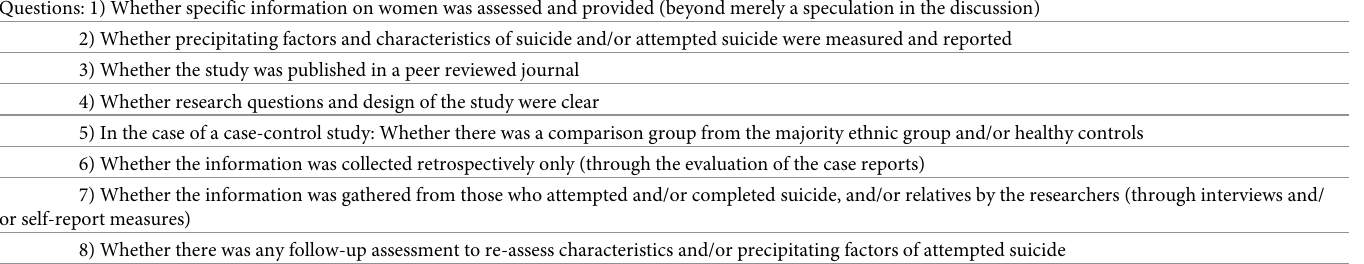
Table 1. Quality assessment of the